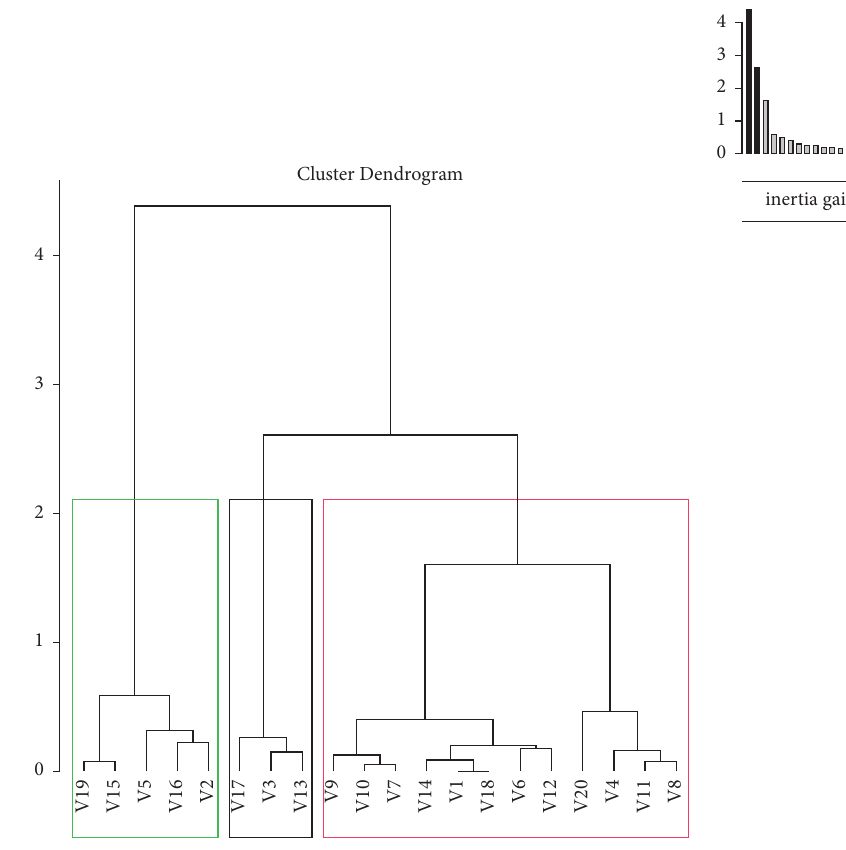
Figure 7: Hierarchical tree under water stress at the reproductive